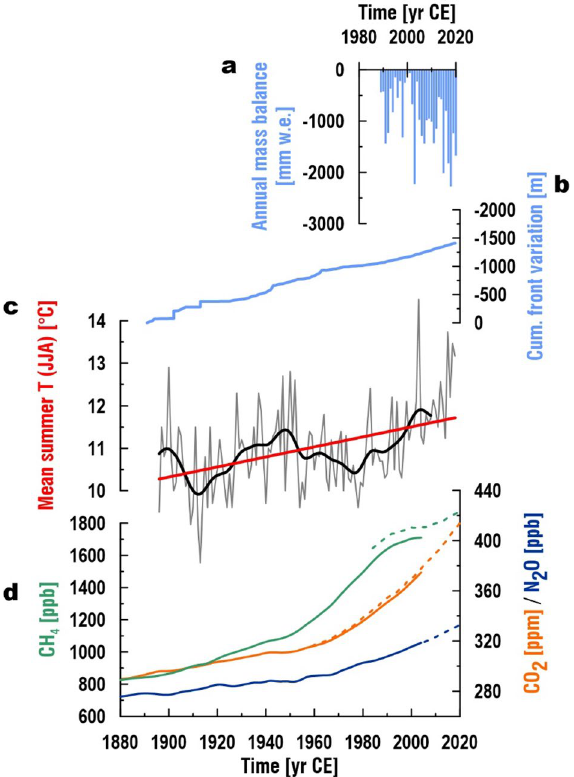
Figure 2. Response of Jamtal glacier to greenhouse gas emissions and rising temperatures over the past decades. (a) Mass balance record of Jamtal glacier (1989–2020 CE) with negative values ranging between − 62 mm water equivalent (w.e.) (2000 CE) and − 2276 mm water equivalent (2018 CE) 20 . (b) Front variation of Jamtal glacier (1891–2019) showing retreat of ca. 1.5 km since 1891 CE 20 . (c) Mean summer temperature (grey line) at meteorological station Galtür (station number: 101949; 1587 m a.s.l.) overlain with 20 years low pass filter (black line) 21,22 . (d) Mean annual atmospheric greenhouse gas concentrations (1880–2004) derived from Law Dome ice core (solid lines) 23 . Globally averaged marine surface annual data of CH 4 (1984–2020 CE; green dashed line), CO 2 (1959–2020; orange dashed line), and N 2 O (2001–2020; blue dashed line) were provided by NOAA Global Monitoring Laboratory 24